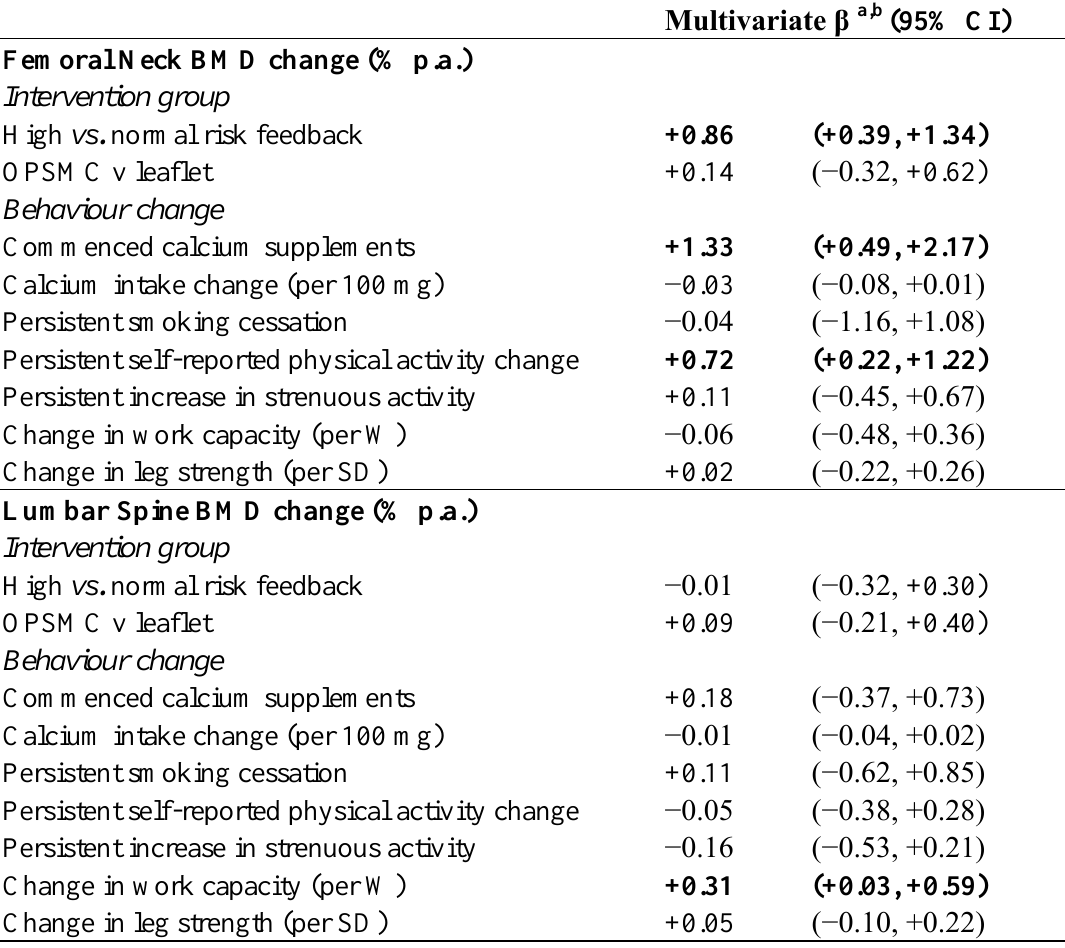
Table 1. Effects of interventions (risk feedback and education) and behavior changes on bone density at the femoral neck and lumbar spine (adapted from Winzenberg 2006